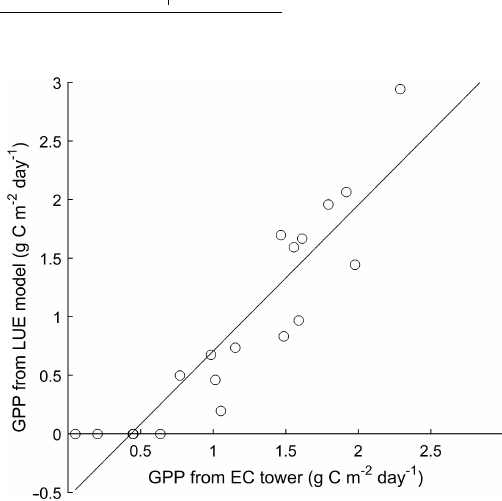
Figure 8. Correlation between GPP from the EC tower and LUE modelled GPP for the year 2012, with insect outbreak. GPP lue , defoliated =− 0.54 × 1.25GPP EC , R 2 = 0 . 83 and N =